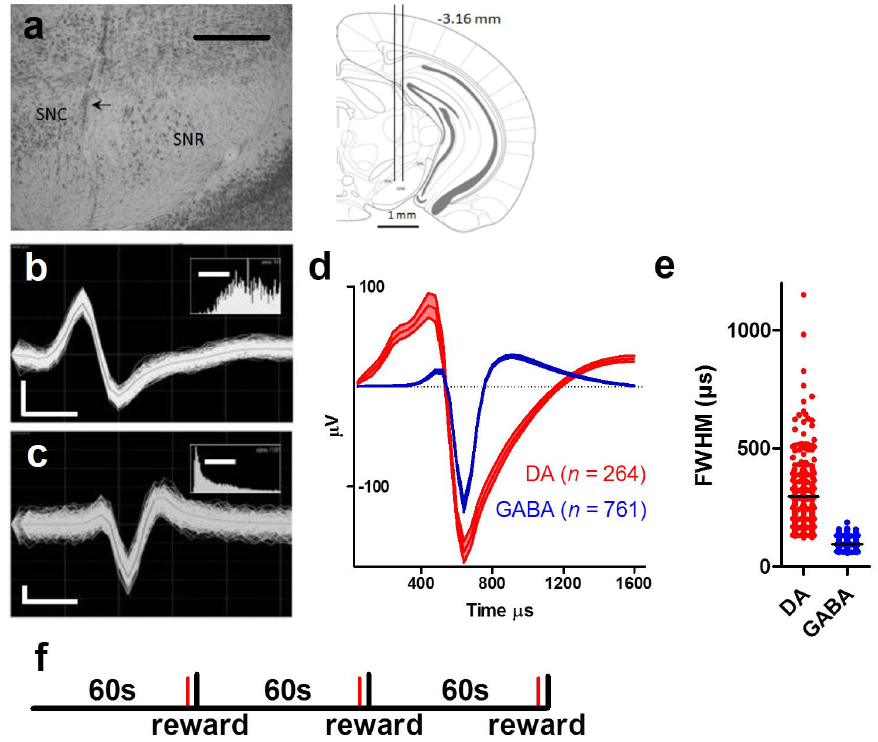
Figure 1. Single unit recording in substantia nigra. ( a ) Representative photomicrograph of electrode tracks in the pars compacta (SNC; arrow; left). Schematic representation of the electrode placement (right; SNR, pars reticulata). Coordinates are relative to Bregma. Sample traces of DA ( b ) and GABA ( c ) neurons showing the narrower spike waveform of GABA neurons. Insets are inter-spike interval histograms. ( d ) Average waveforms ( 6 s.e.m.) for all recorded DA and GABA neurons. We classified the neurons based on the waveforms of their action potentials. DA neurons, for example, are characterized by longer spike durations than GABA neurons. n is indicated by the numbers. ( e ) Full width half max (FWHM) values of classified DA and GABA neurons. ( f ) Schematic illustration of the FT60 task. One pellet was delivered into the food cup every 60 s (vertical black lines). An auditory cue preceded the pellet delivery by , 550 ms (red lines). Vertical scale bars represent 68 m V ( b ) and 23 m V ( c ), and horizontal scale bars represent 500 m m in a , and 200 m s in b and c (10 ms in insets).